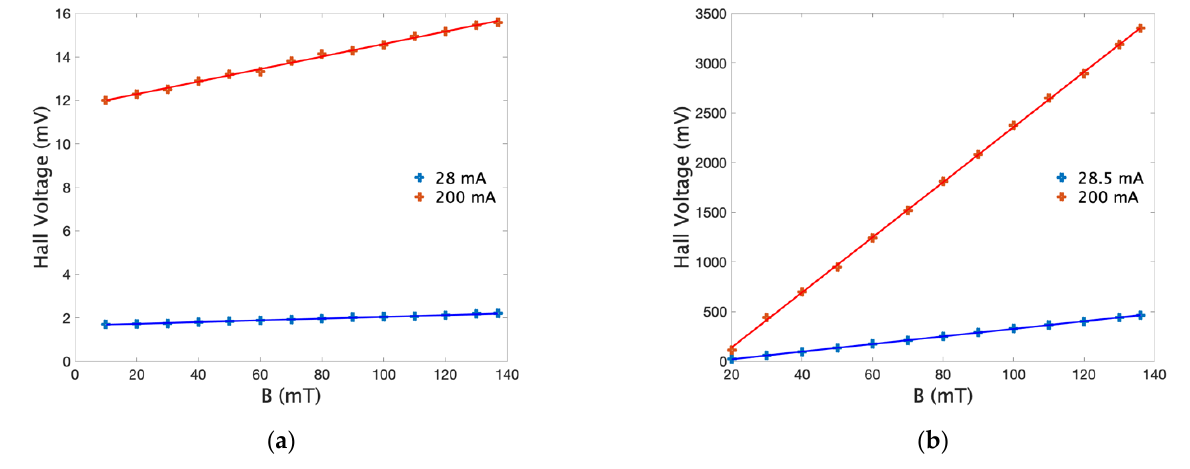
Figure 6. Hall Effect measurements for ( a ) graphene on SiO 2 and ( b ) graphene on hBN/SiO 2 . Table 1. Summary of carrier density and mobility from TLM and Hall effect methods on both dielectric